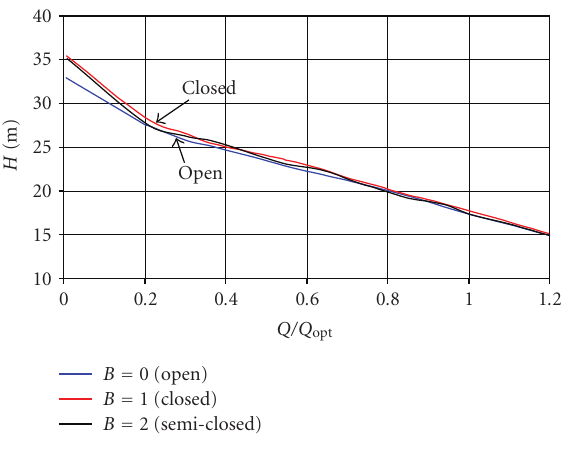
Figure 8: Head flow curve ( n = 725rpm).